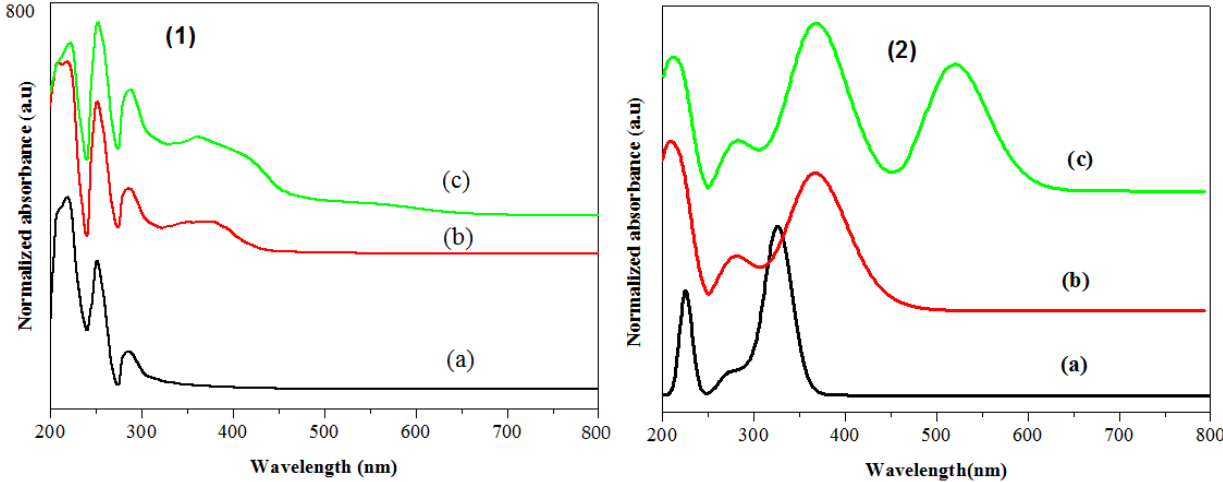
Figure 14. OA spectra of PANI in various states: ( 1 ) experimental and ( 2 ) theoretical; ( a ) neutral, ( b ) doped, and ( c ) the nanocomposite.